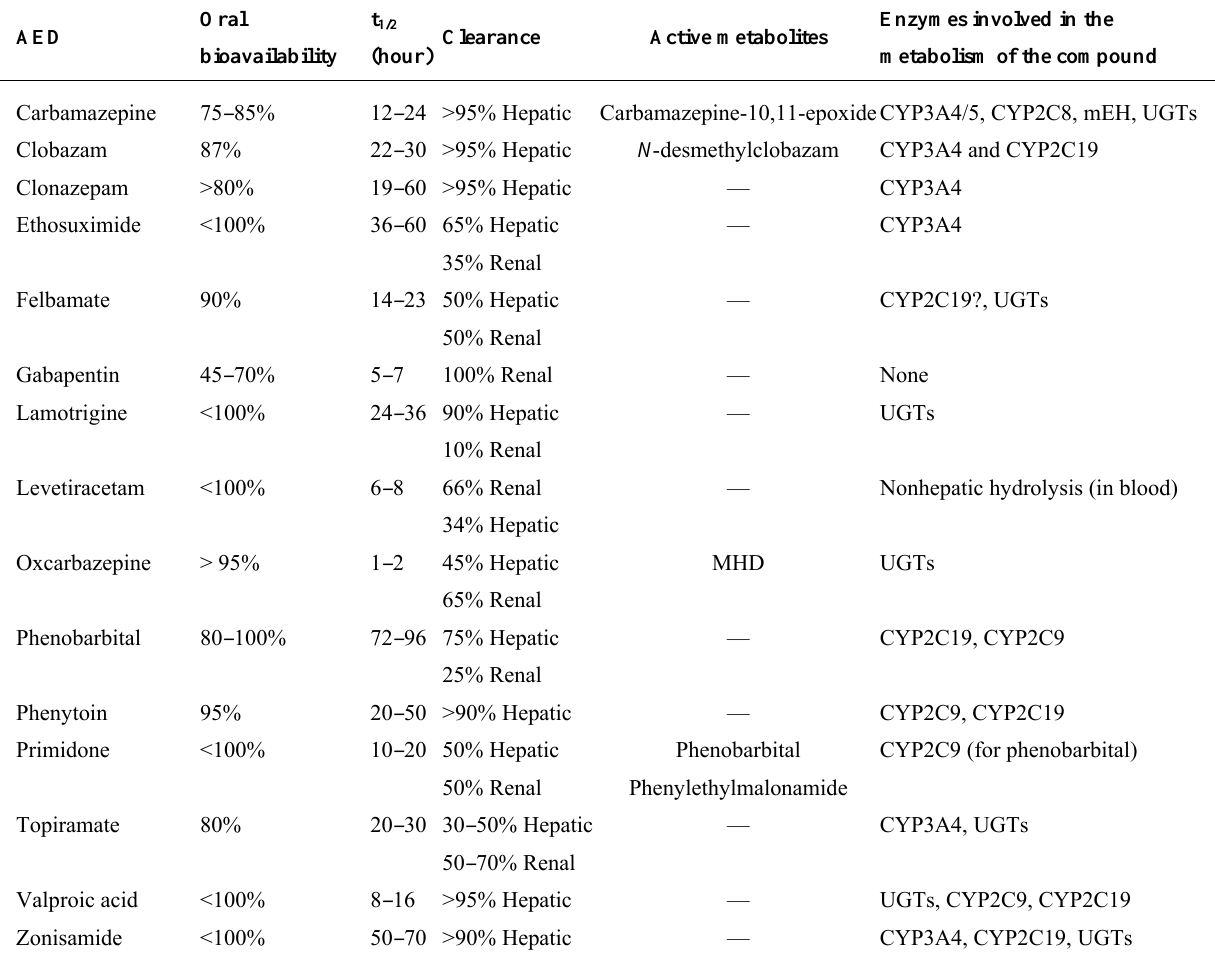
Table 1. Pharmacokinetic characteristics of antiepileptic